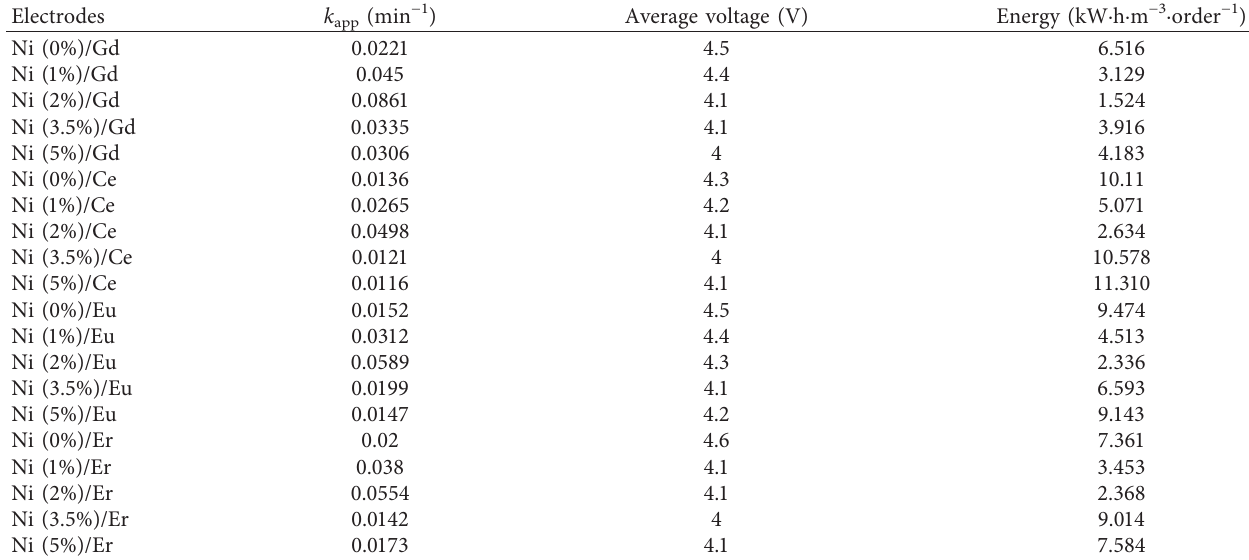
Table 12: Energy per order of decolorized 40mg · L − 1 RhB solution, evaluated from equation (5), and electrochemical decolorization of Ti/ SnO 2 -Sb-Ni/Re electrodes with various Ni contents and different rare earth elements in 200ml dye solution.